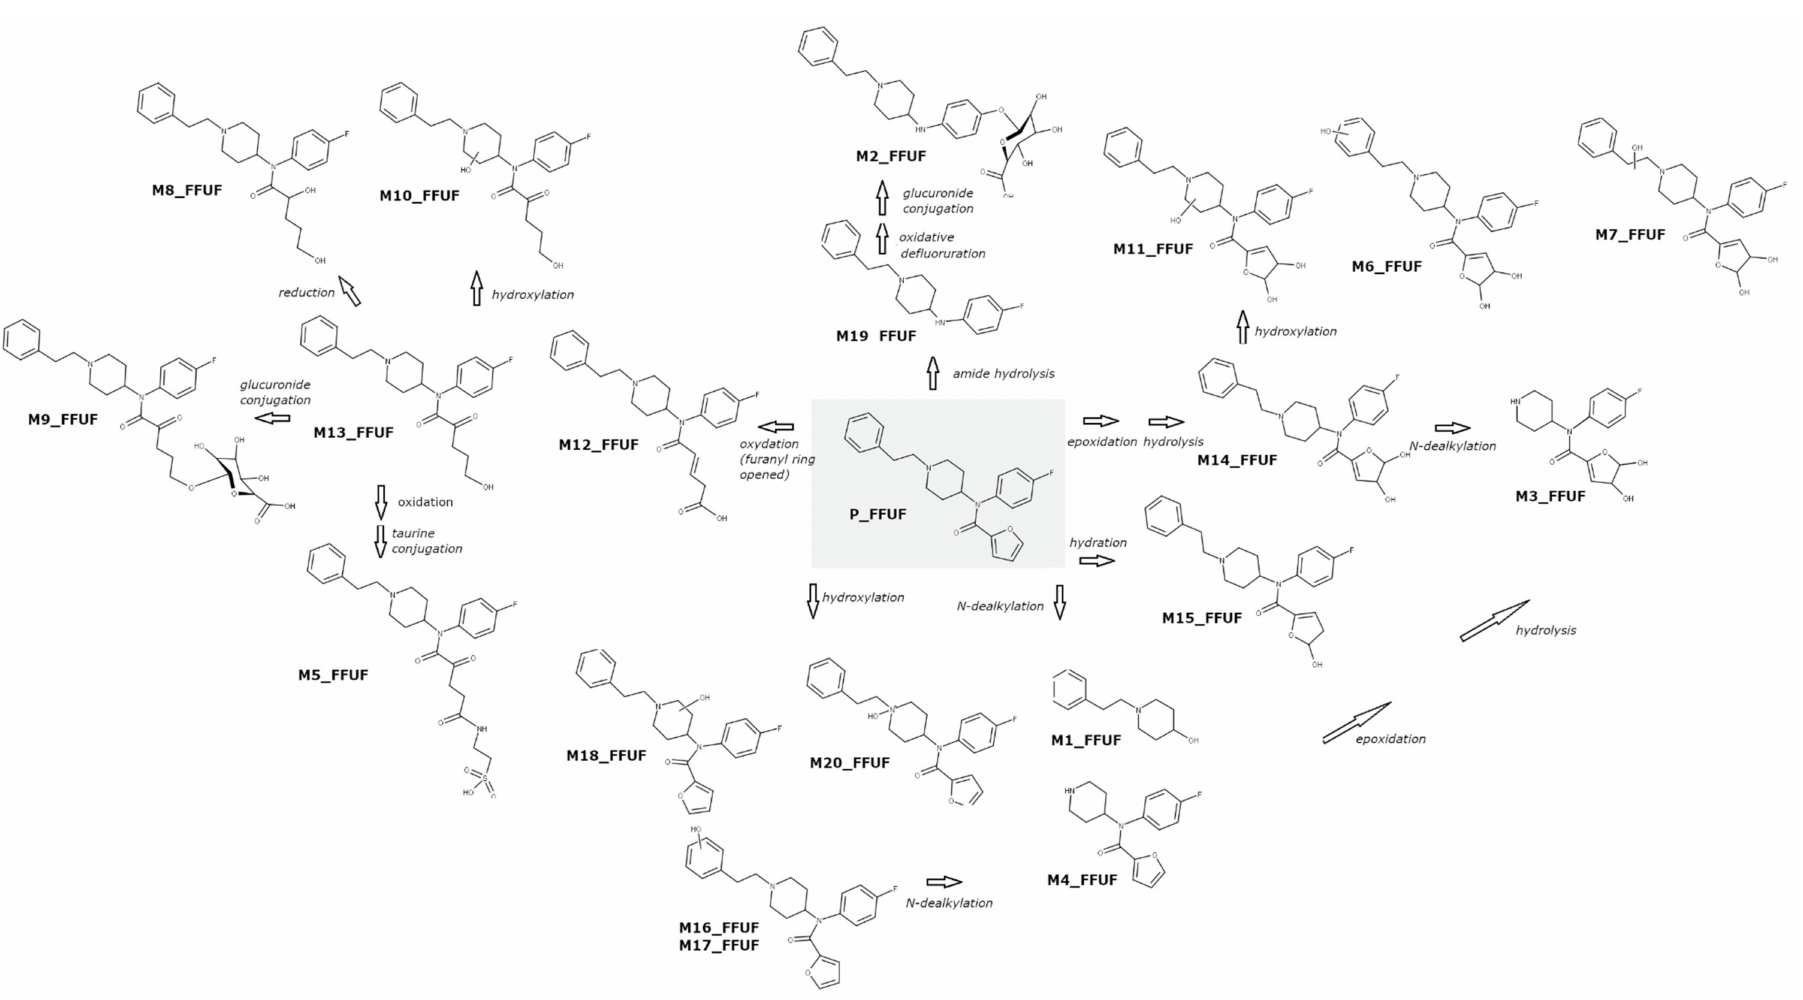
Figure 1. Proposed metabolic pathway of 4-fluoro-furanylfentanyl combining both the in vitro and in vivo